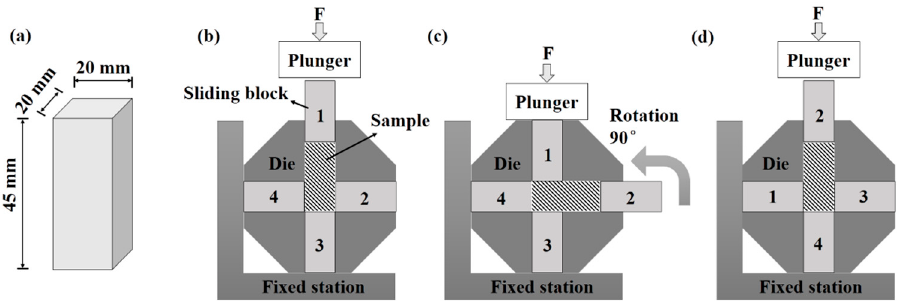
Figure 1. Schematic diagram to show the setup of rotational die (RD)-equal channel angular pressing (ECAP) processing: ( a ) Dimension of the ECAP sample; ( b ) initial state of first pass; ( c ) final state of first pass; ( d ) initial state of second pass.